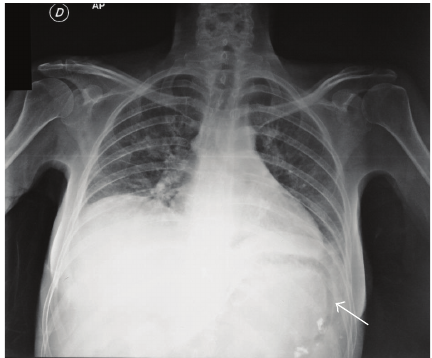
Figure 2: Plain chest X ray. Radiolucent image below the left diaphragm showing the presence of air within the wall of the stomach (arrow).